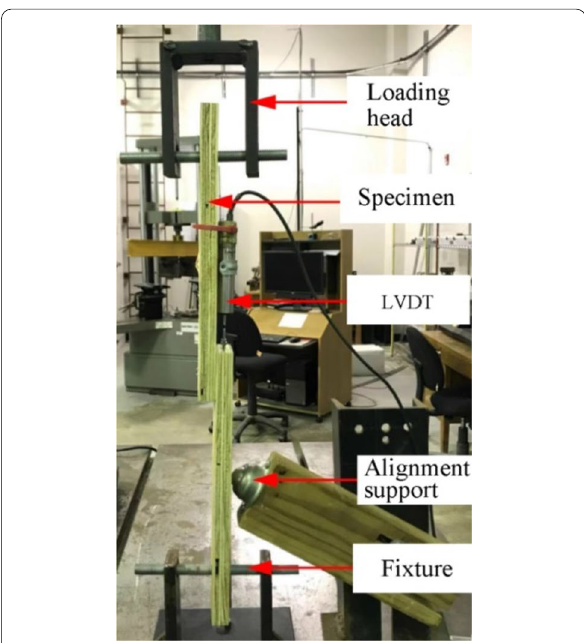
Fig. 5 Test setup for evaluating the lateral load–slip behavior of single-shear plywood-to-plywood single-staple connections